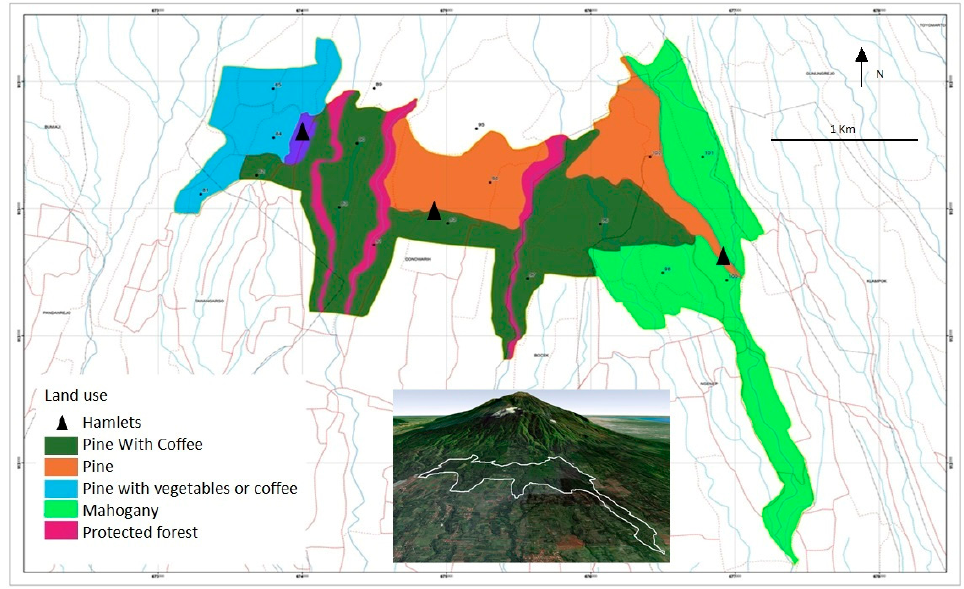
Figure 1. UB Forest area. Map shows the forest types and the location of the hamlets, photo insert shows forest location on the slopes of the volcano Mount Arjuna.